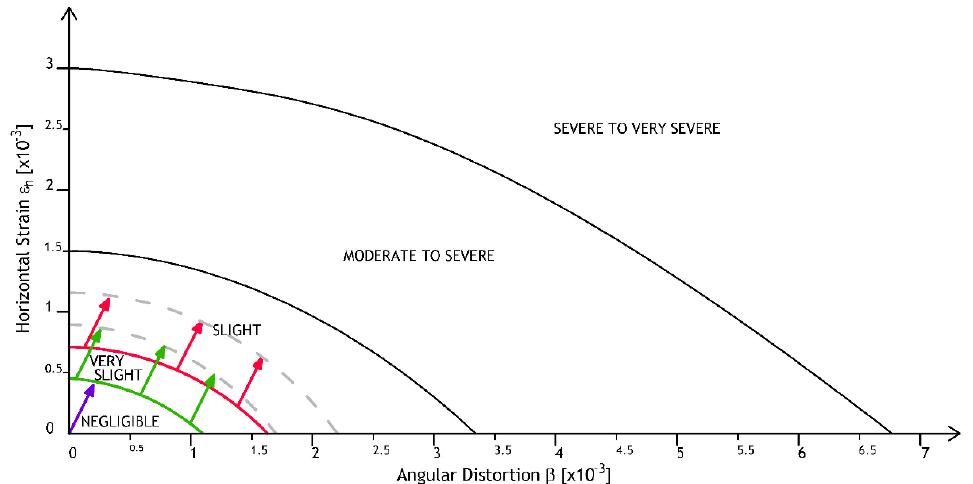
Figure 15. Damage assessment for the considered case study building wall, based on Boscardin and Cording scheme [28], as a function of the angular distortion β and horizontal strain ε h , by conceptually knowing the damage state at the beginning of the monitoring period.